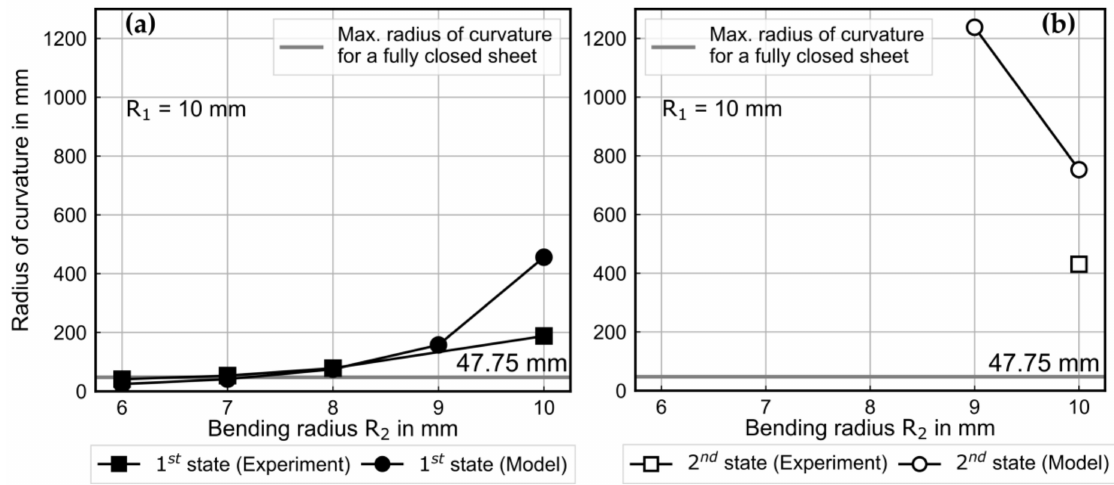
Figure 15. Radii of curvature for first ( a ) and second ( b ) stable state after first bending operation with a radius R 1 = 10 mm and various second bending radii R 2